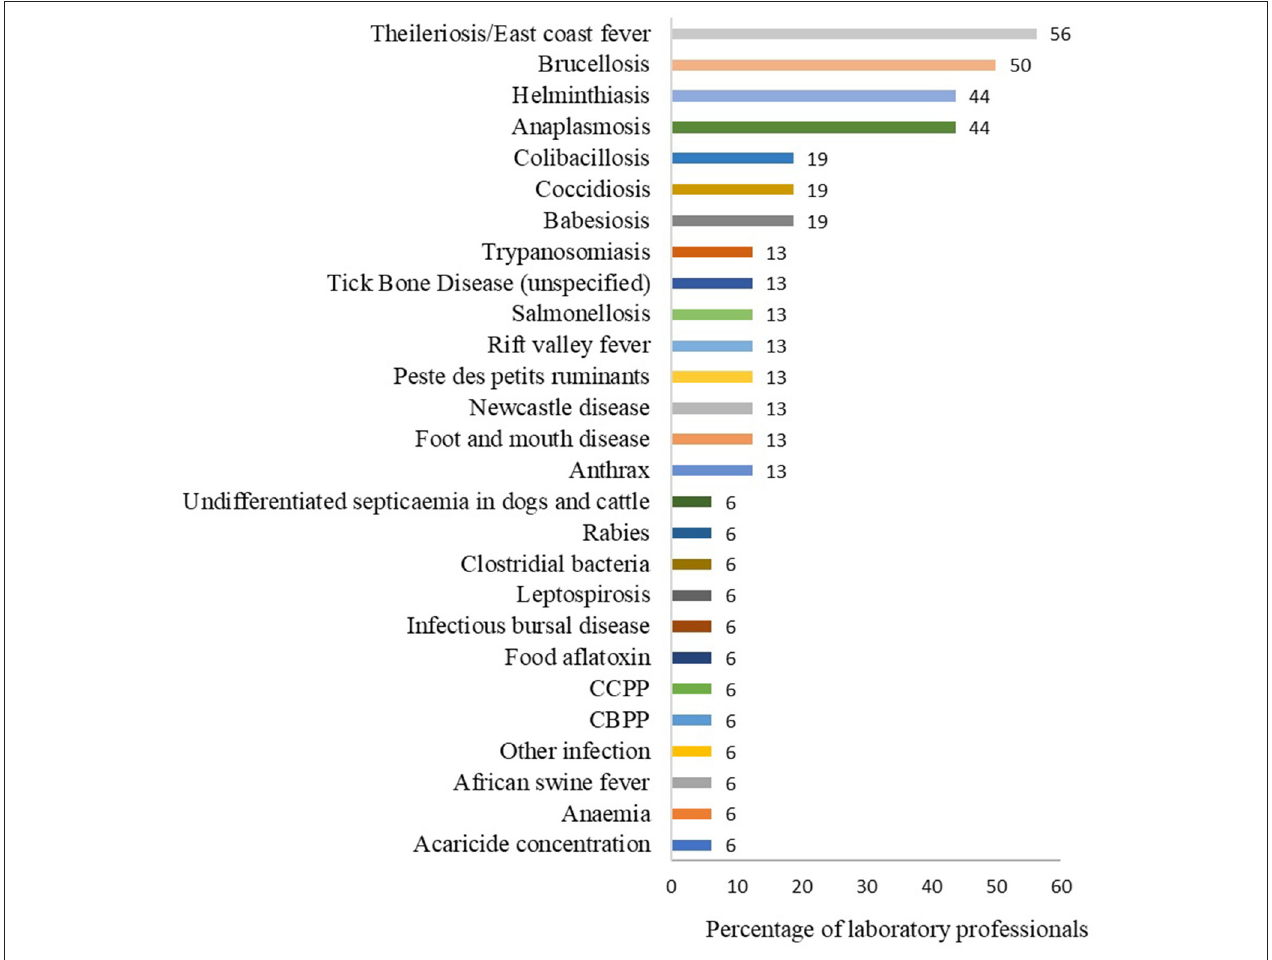
FIGURE 4 | The most tested diseases in the laboratory. This question had multiple responses. Bars represent percent of laboratory technicians ( n = 16) that selected each